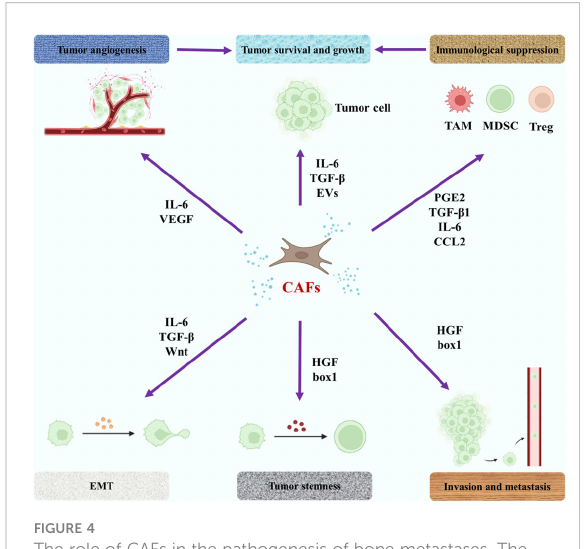
FIGURE 4 The role of CAFs in the pathogenesis of bone metastases. The purple arrow represents an in fl uence. EMT, epithelial- mesenchymal transition; PGE2, prostaglandin E2; EVs, extracellular vesicles; HGF, hepatocyte growth factor; VEGF, vascular endothelial growth